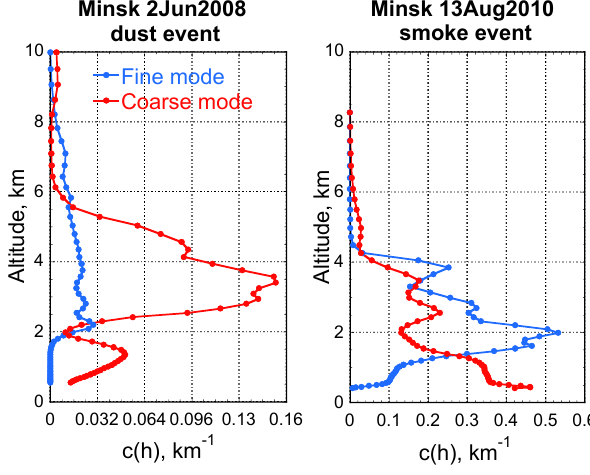
Fig. 16. Retrieved vertical concentration profiles.